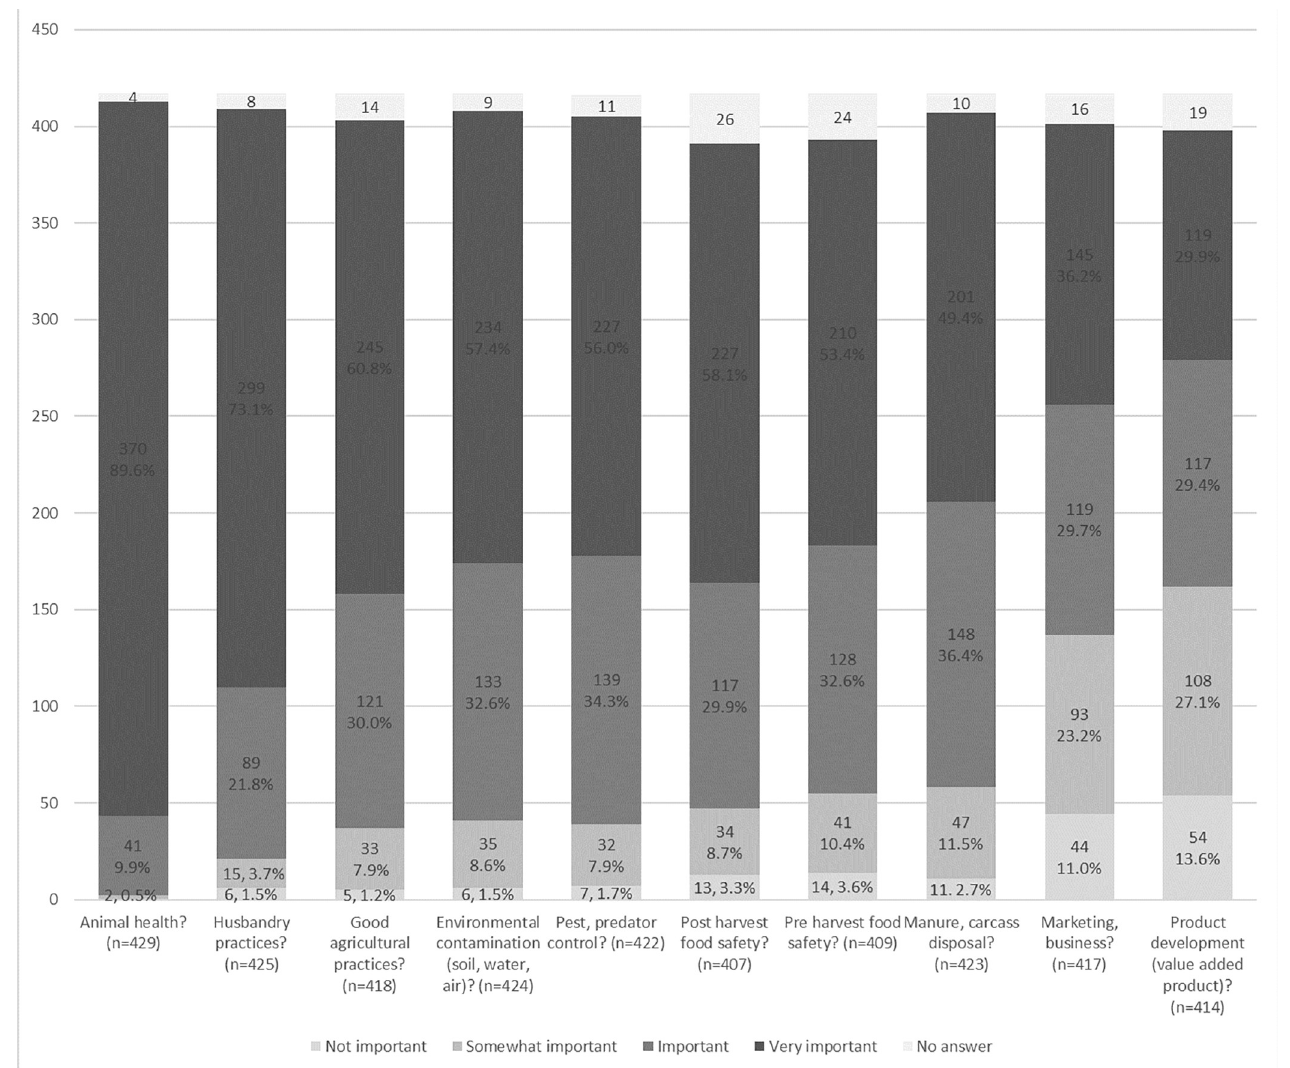
Fig 3. Perceptions of animal health, husbandry practices, pest control, food safety and marketing by small-scale livestock and poultry owners in 4 western states (Washington, California, Colorado and Oregon). Footnote : Proportions are given as the valid percentage: the percentage only of individuals who answered the question, and do not count no